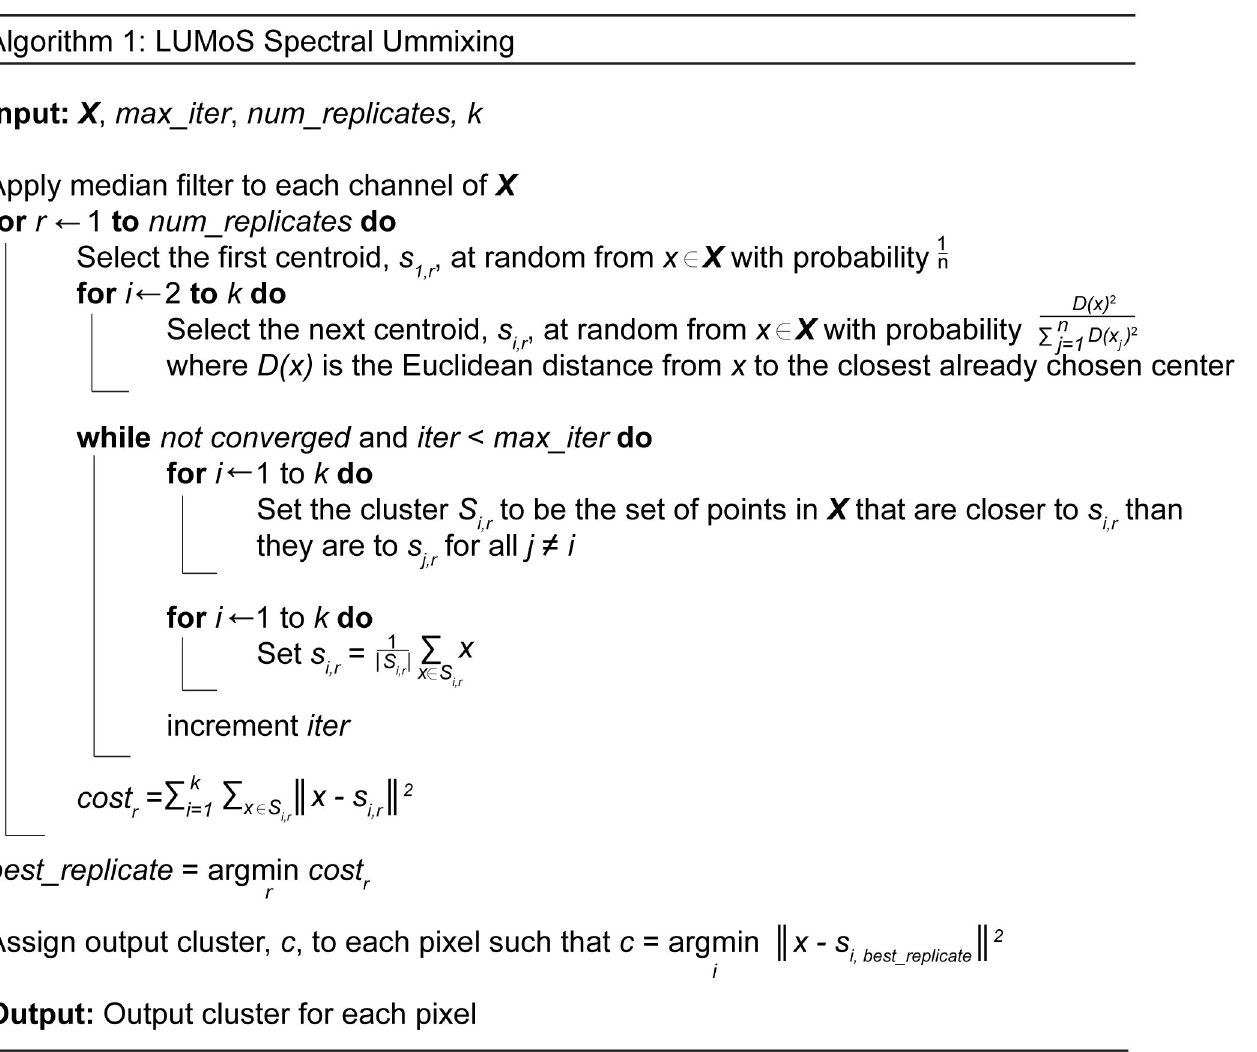
Fig 1. LUMoS spectral unmixing